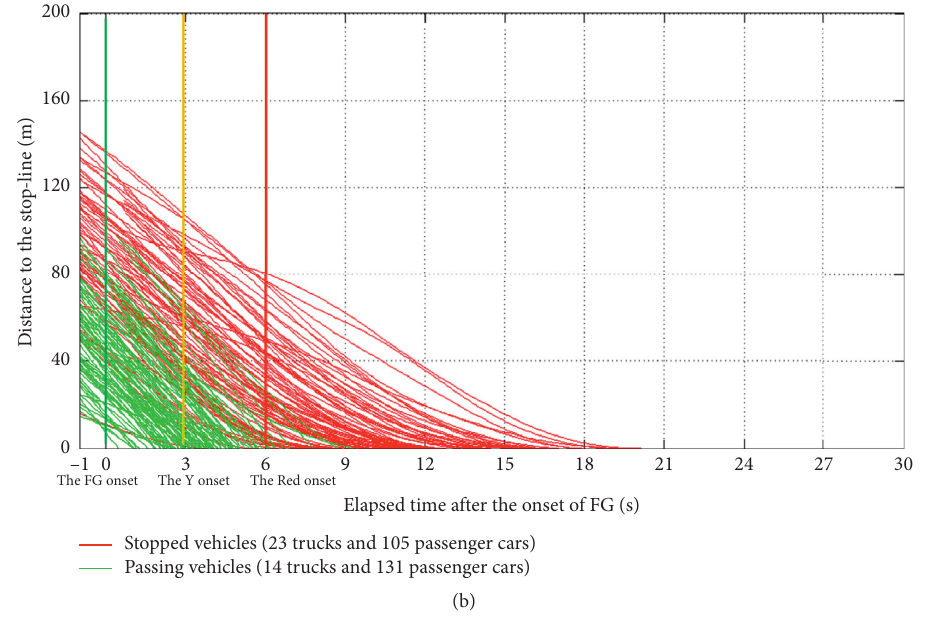
Figure 1: Vehicle trajectory data of the investigated intersections. (a) Rural intersections (the speed limit is 80km/h) and (b) urban intersections (the speed limit is 50km/h).